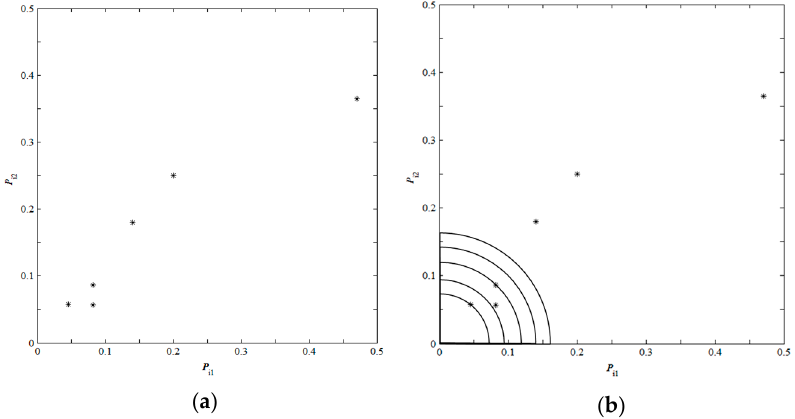
Figure 11. Deletion of points: ( a ) normalized weighted point and ( b ) deletion method of concentric quadrants.